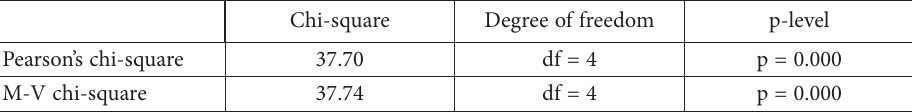
Table 15. χ 2 test for motivational factor job security from the point of view of gender Chi-square Degree of freedom p-level Pearson’s chi-square 37.70 df = 4 p = 0.000 M-V chi-square 37.74 p =